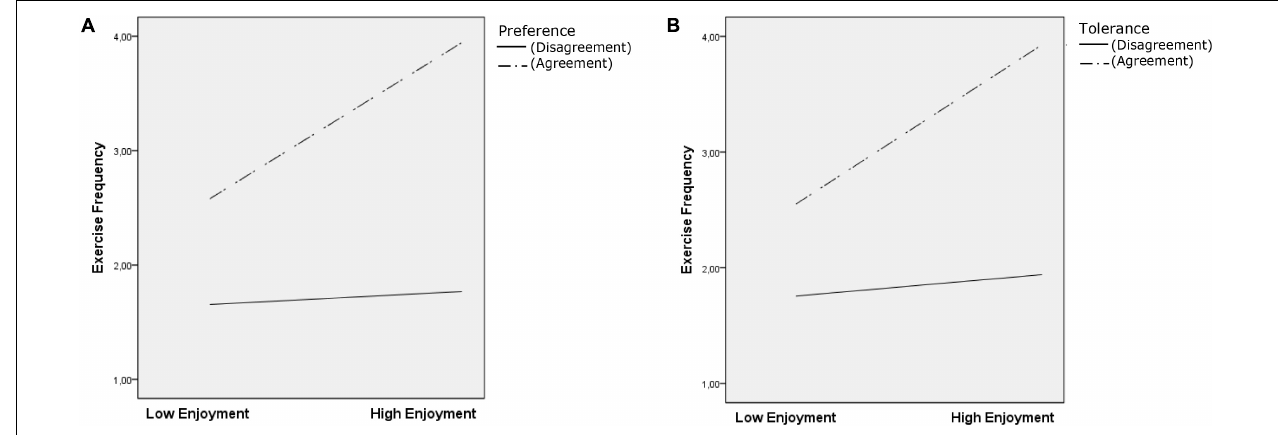
FIGURE 3 | Conditional effects analysis for the preference and tolerance levels of agreement/disagreement on exercise